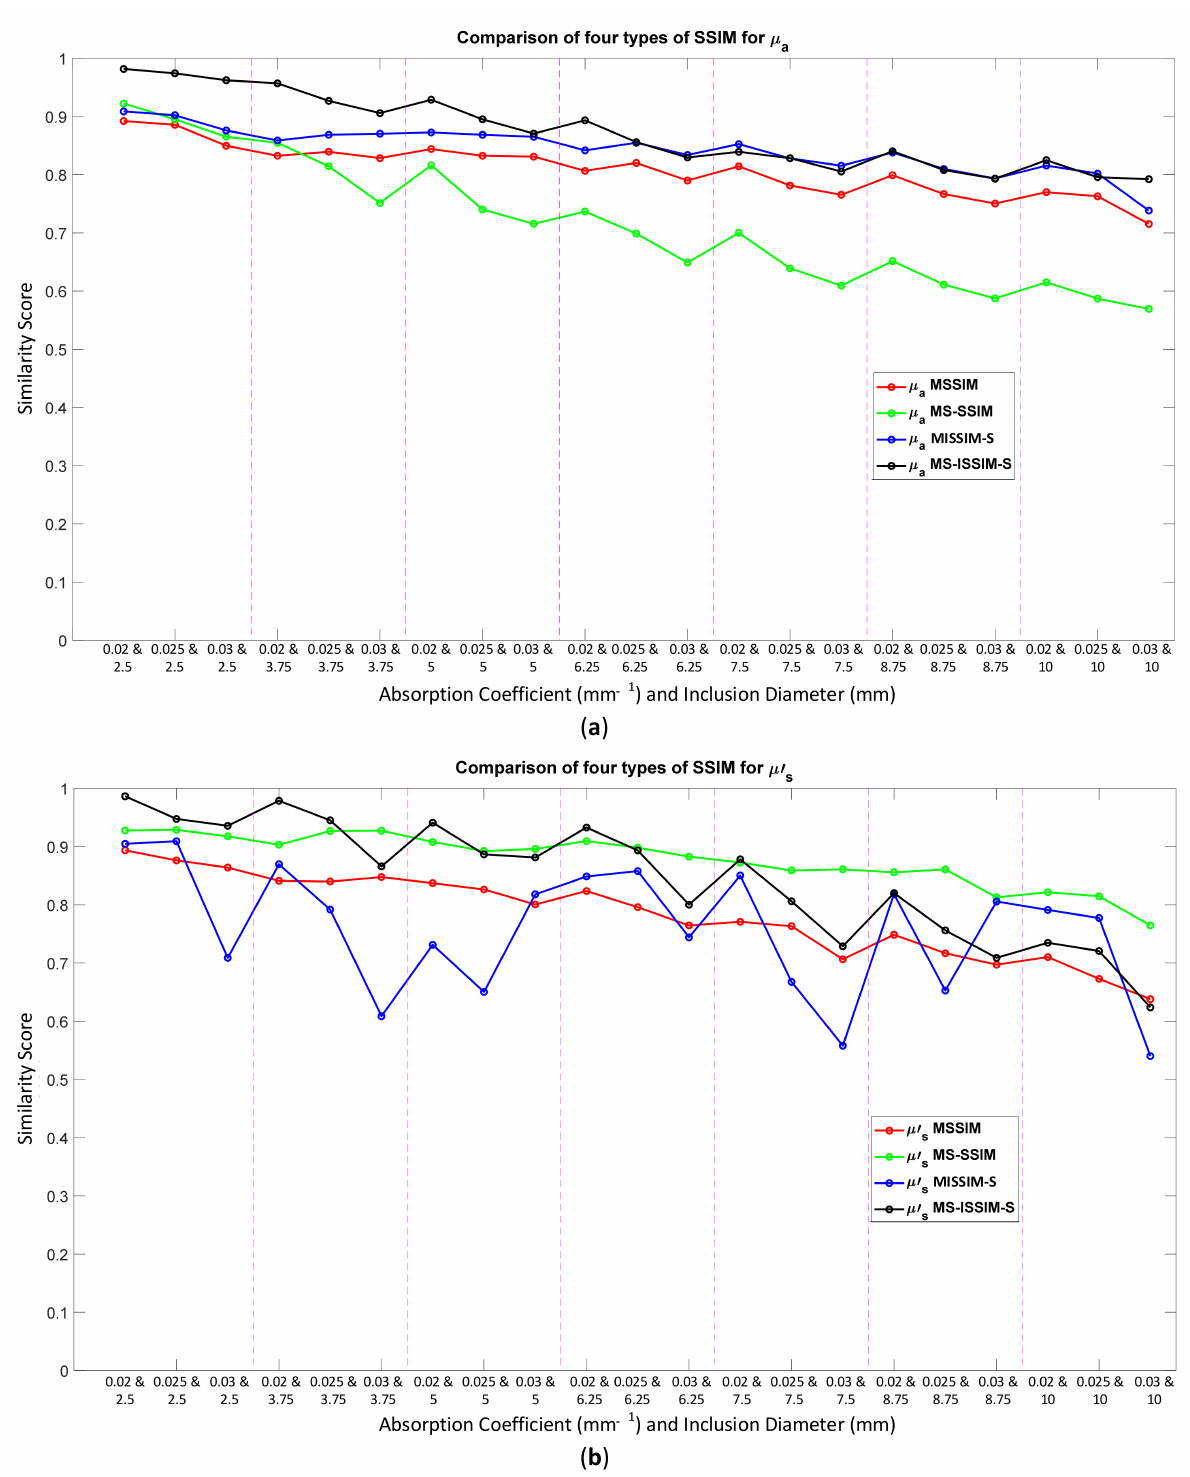
Figure 15. Four types of SSIM similarity score of case B2 with 1% noise amplitude for ( a ) µ a and ( b ) µ (cid:48) s